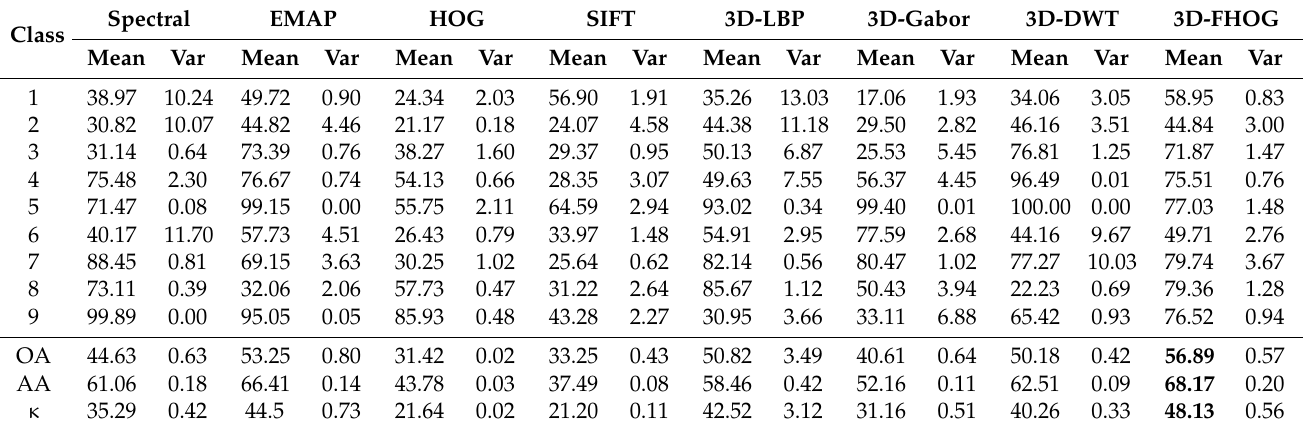
Table 6. Classification results (%) for Spectral, EMAP, HOG, SIFT, 3D-LBP, 3D-Gabor, 3D-DWT, and